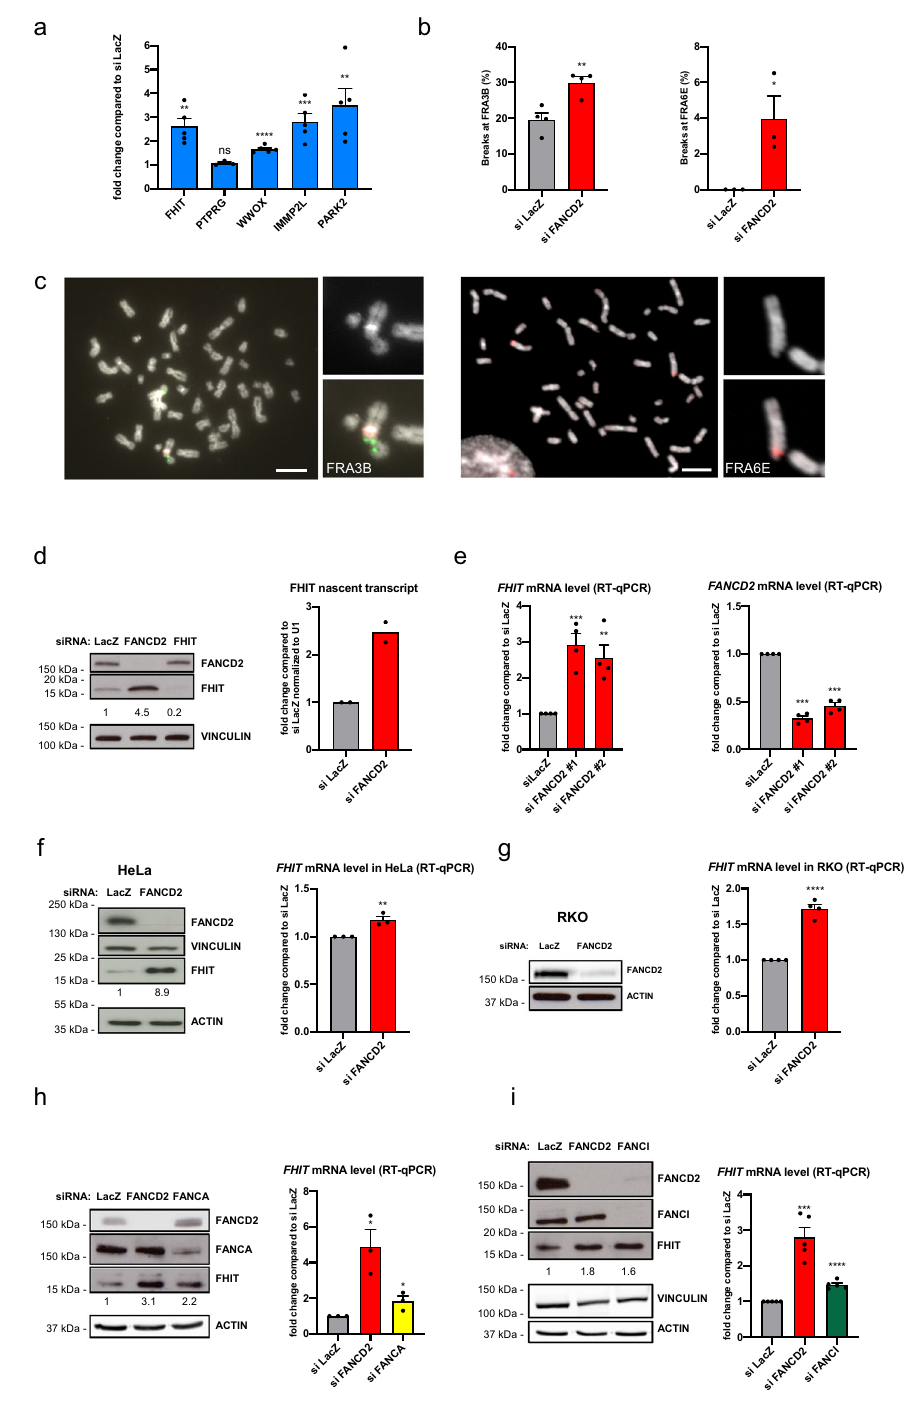
instability 45 . FRA3B breaks were signi fi cantly reduced in FHIT - consistent with transcription inducing CFS instability.